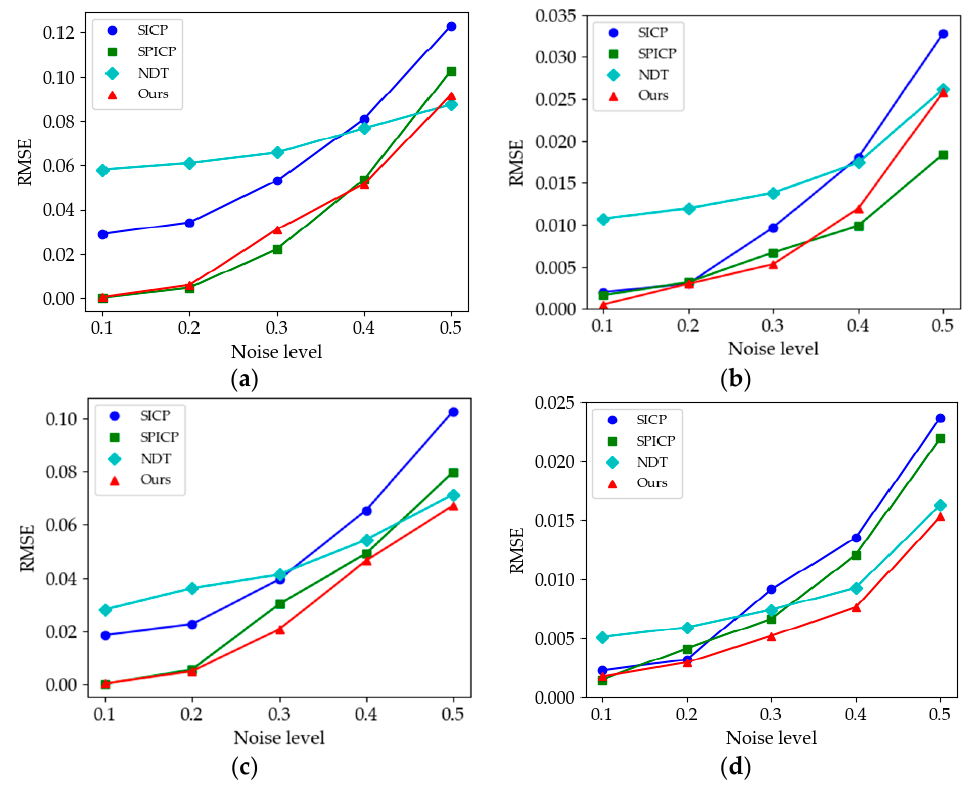
Figure 12. Comparison of average RMSE of the four algorithms at different noise levels for different point clouds. ( a ) Comparison results of M 1 point cloud; ( b ) M 2 ; ( c ) M 3 ; ( d ) M 4 .